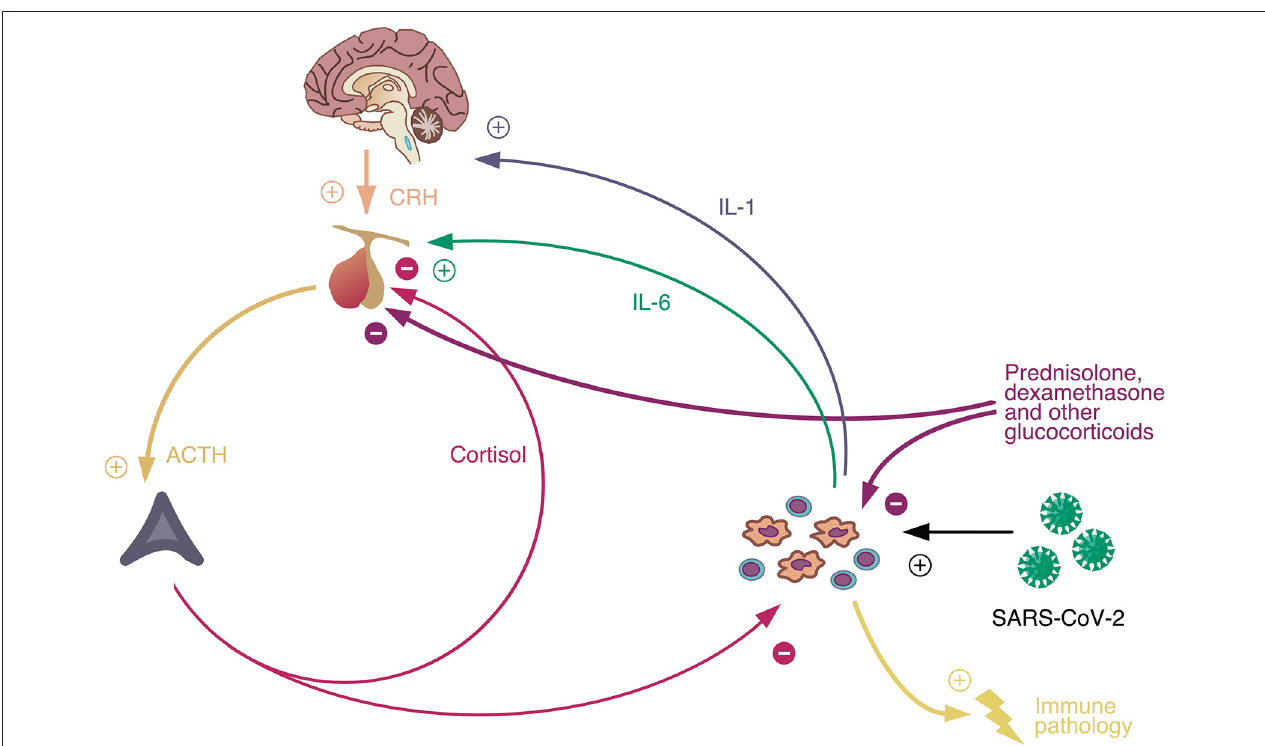
FIGURE 5 | Interaction of the HPA axis with the immune system in COVID-19: Antagonistic convergence on ACTH production by inhibitory cortisol feedback and activating interleukin-6 that is released by macrophages after contact with SARS-Cov-2. The structure of the feedback loop explains the glucocorticoid paradox in COVID-19, i.e., that elevated serum concentrations of cortisol are associated with poor prognosis but that pharmacological use of glucocorticoids like prednisolone or dexamethasone leads to improved outcomes. For more details see